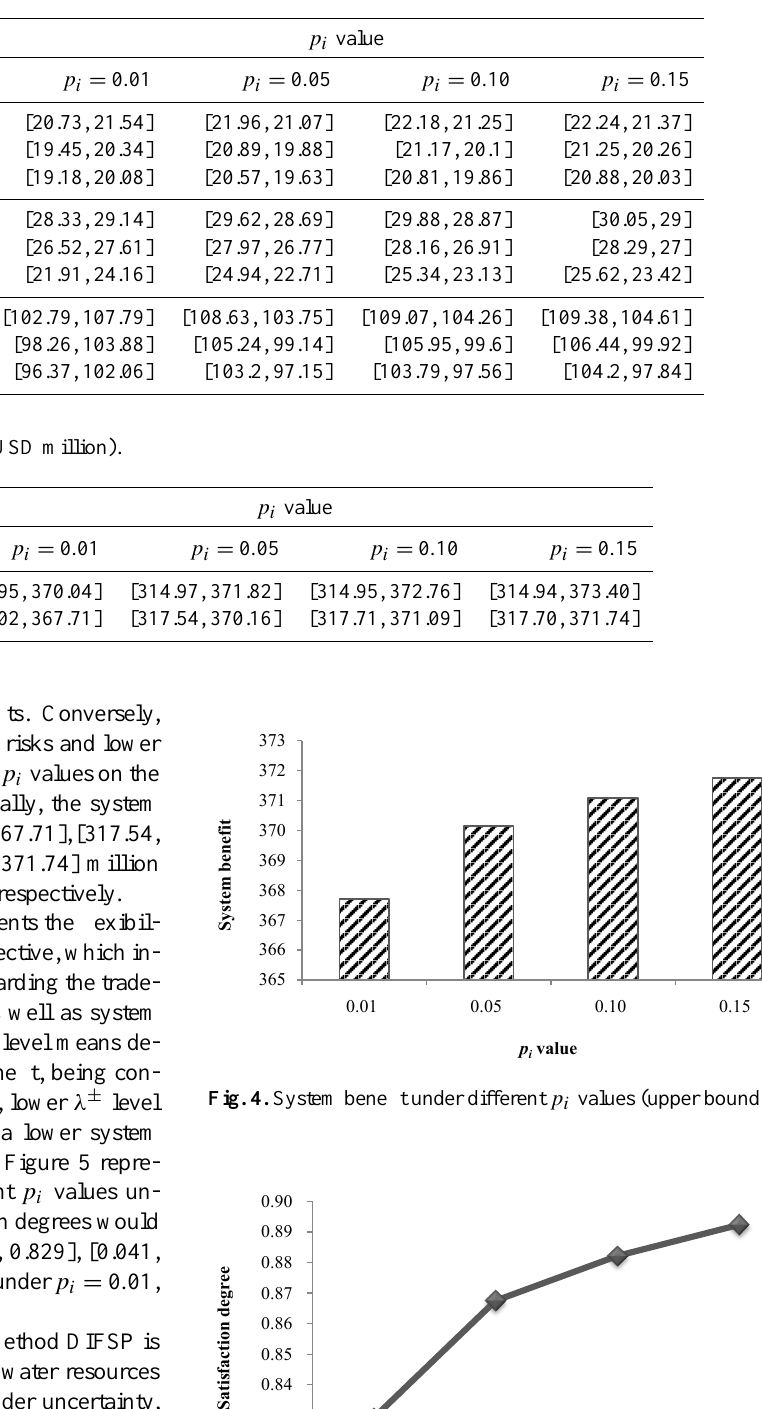
Table 7. Water resources supplies under different p i values (millionm 3 ) .